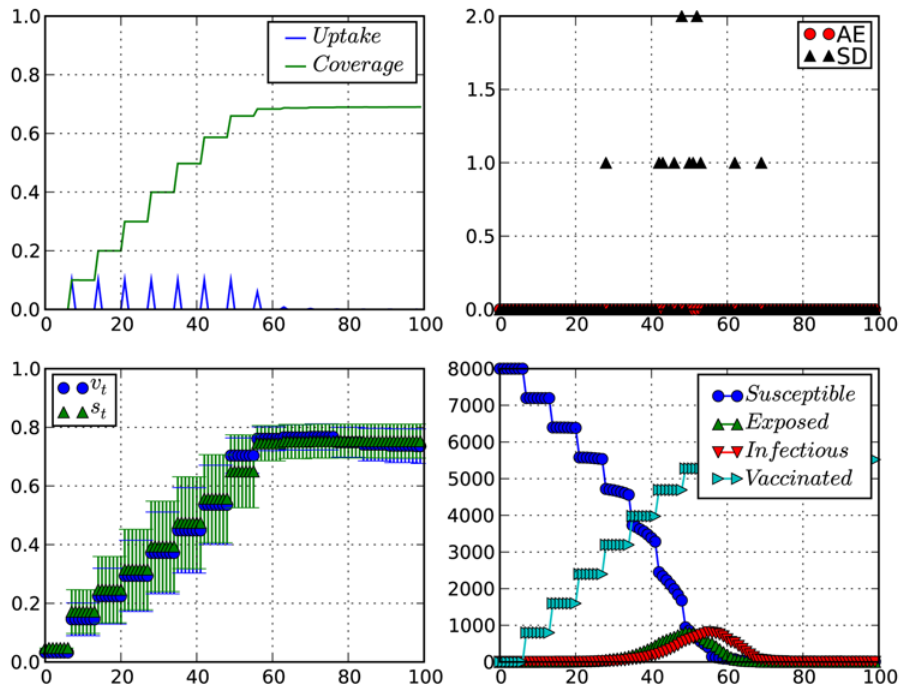
Figure 3. Impact of occurrence of serious disease events at the beginning of a vaccination campaign. Top-left: vaccination coverage and vaccine uptake ( 6 8000 doses);top-right: adverse vaccination and serious disease events; Bottom-left: willingness to vaccinate ( v t ) and perceived vaccine safety ( s t ); Bottom-right: Epidemiological time-series. Time is in weeks. p ae ~ 0 : 0001 ; p sd ~ 0 : 01 .